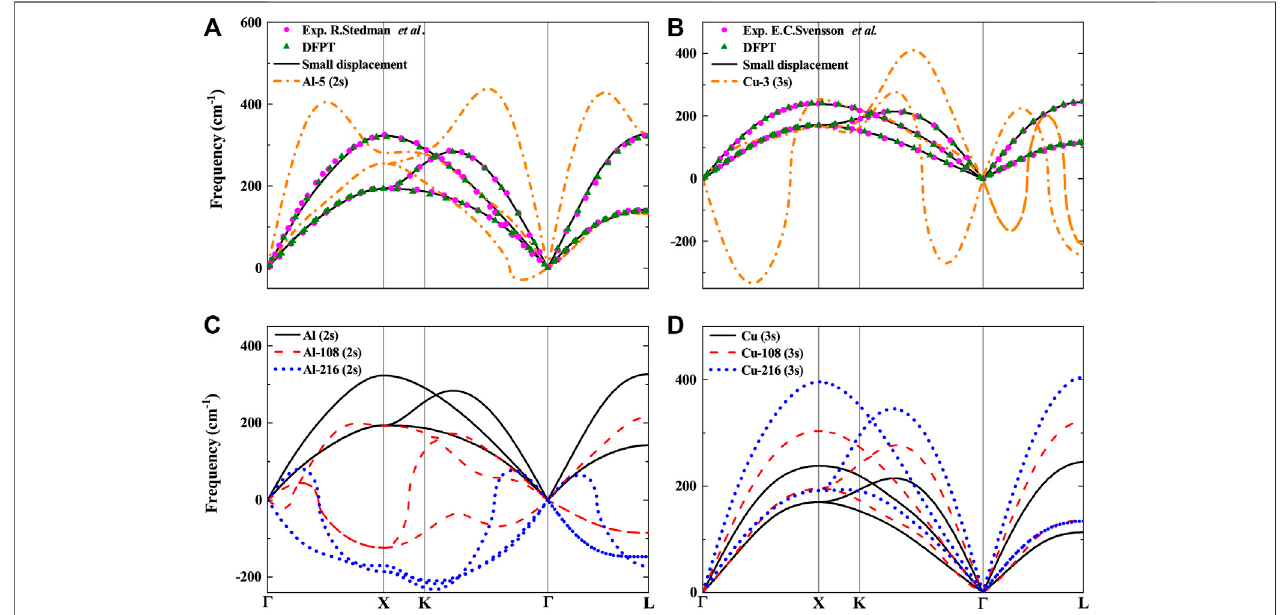
Frontiers in Physics |